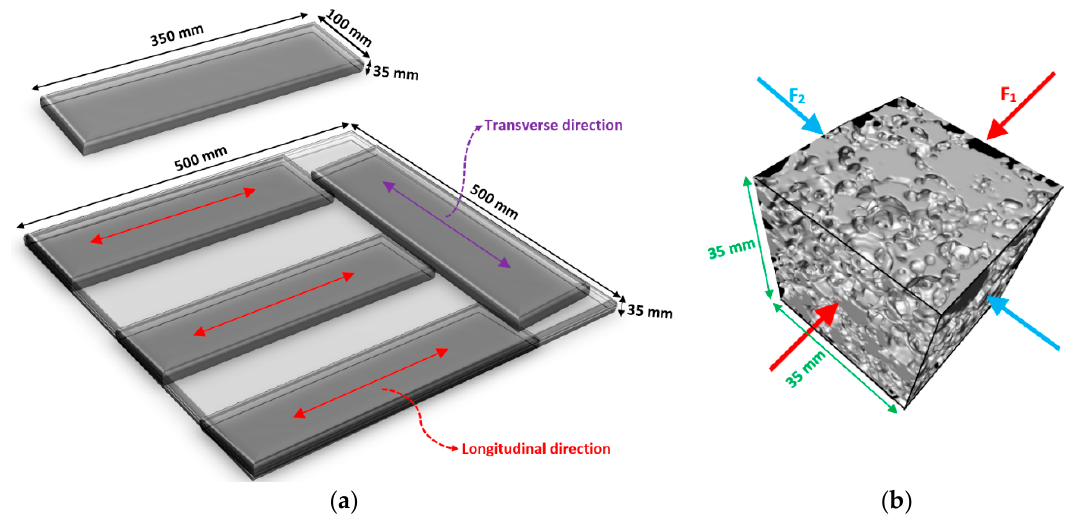
Figure 3. ( a ) The extracted prismatic beams; ( b ) directions of applied compressive loads.